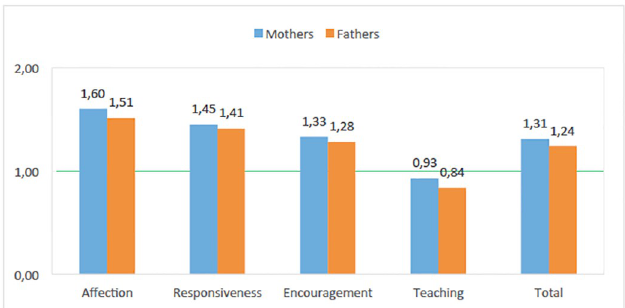
Fig 1. PICCOLO domain and total mean scores for mothers and